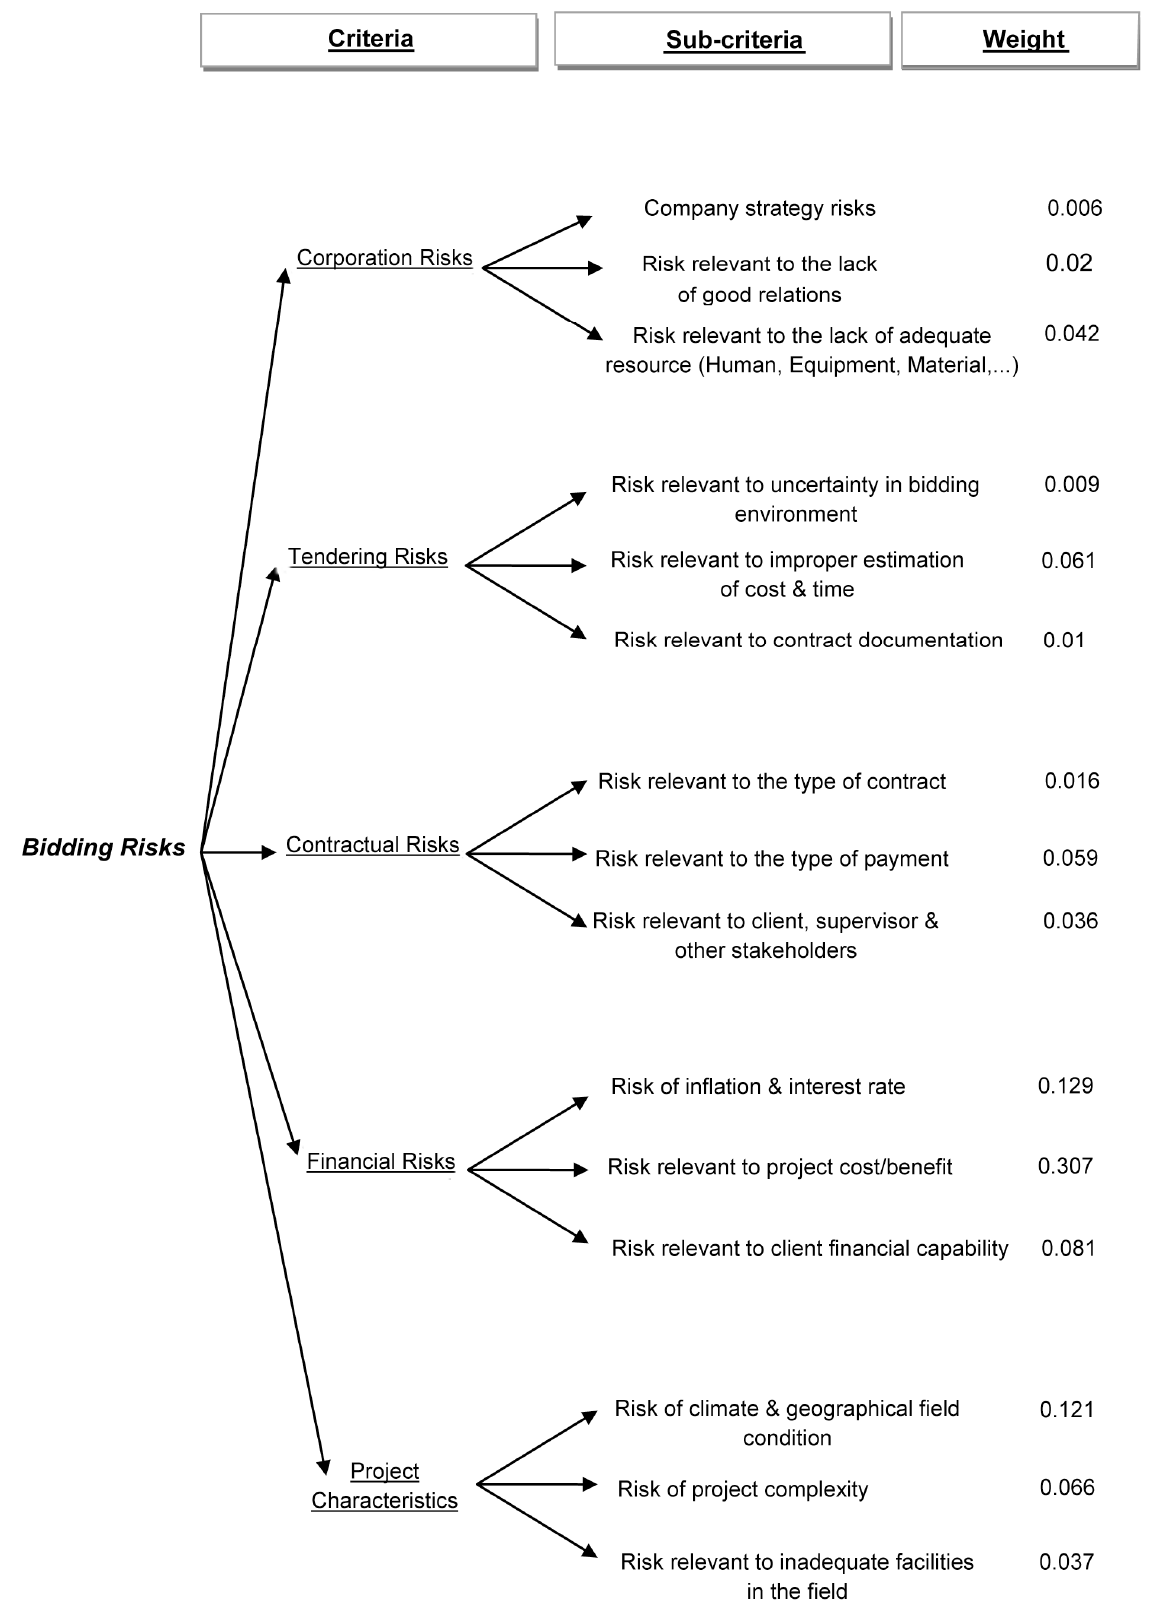
Fig. 3. Bidding risks categorization and